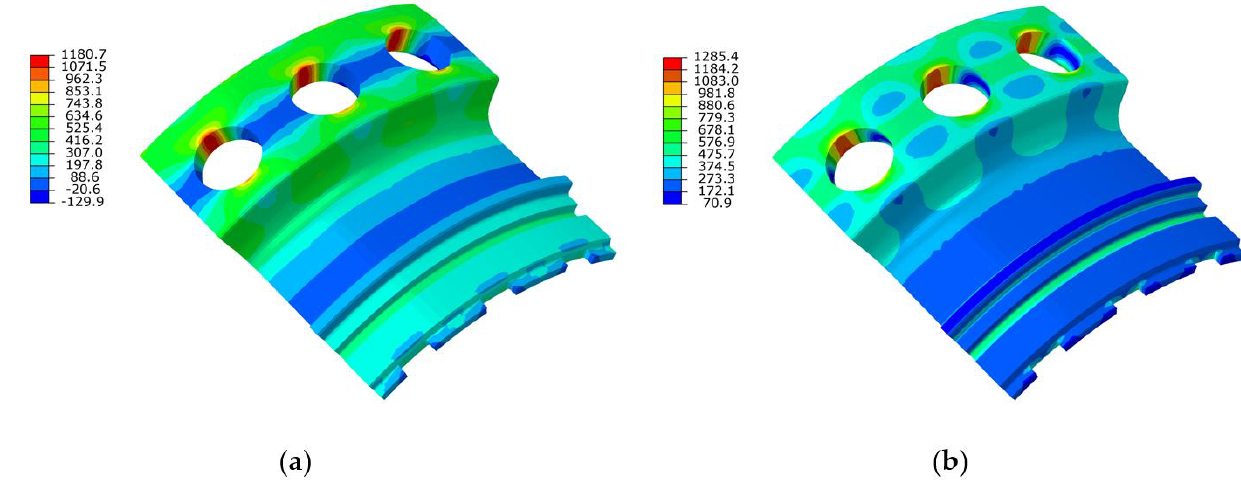
Figure 9. Stress distribution of support ring under test condition (120% relative speed, unit: MPa): ( a ) Hoop stress; ( b ) Equivalent stress. Table 2. Comparison of the maximum stress between the working condition and test condition.